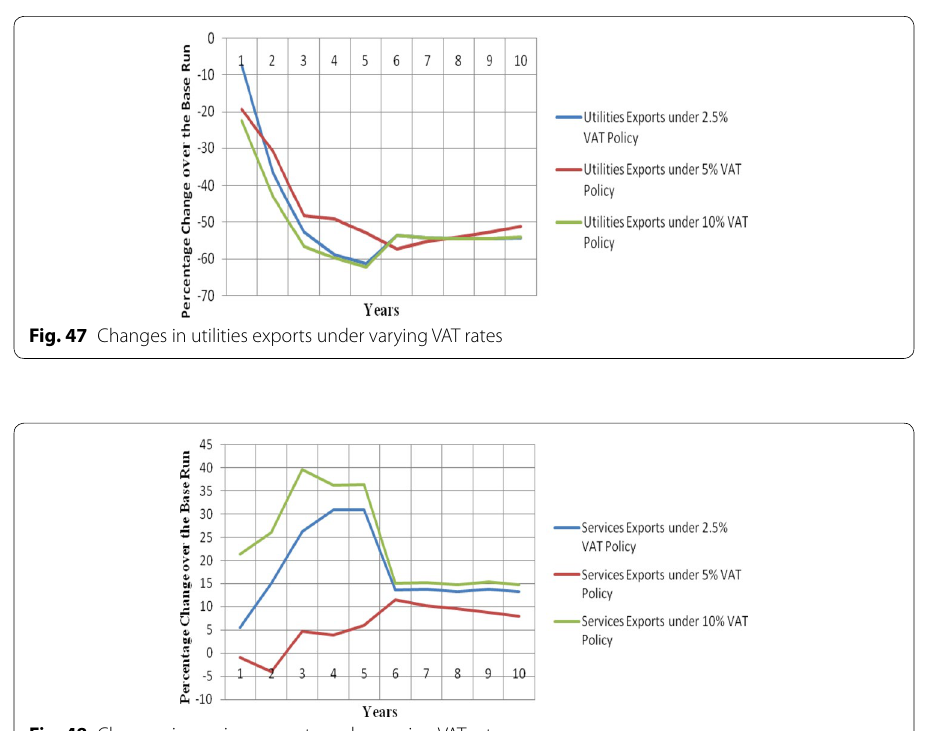
Fig. 48 Changes in services exports under varying VAT